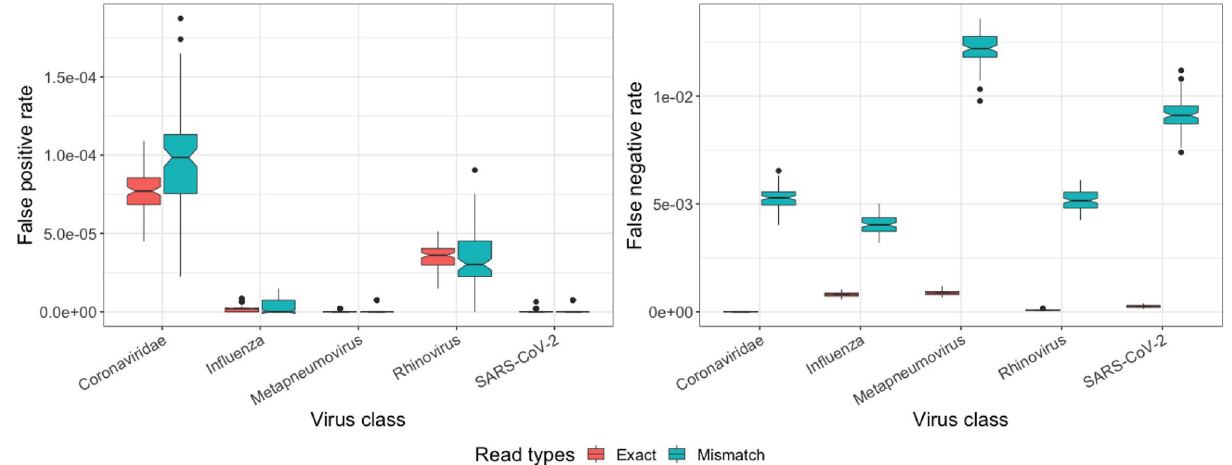
Figure 3. False positive (left panel) and false negative (right panel) rates for reads identical to the corresponding reference genome (Exact, red), and for reads with mismatches with respect to their reference genome (Mismatch, green).